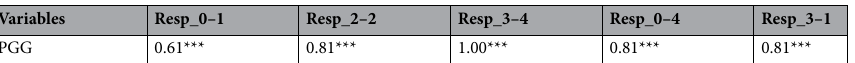
Table 6. OLS Estimates for Specification (7). Resp_0–1 describes contributions after being told that partner A contributed 0 tickets, and that B contributed 1 ticket. Resp_2–2 describes contributions after being told